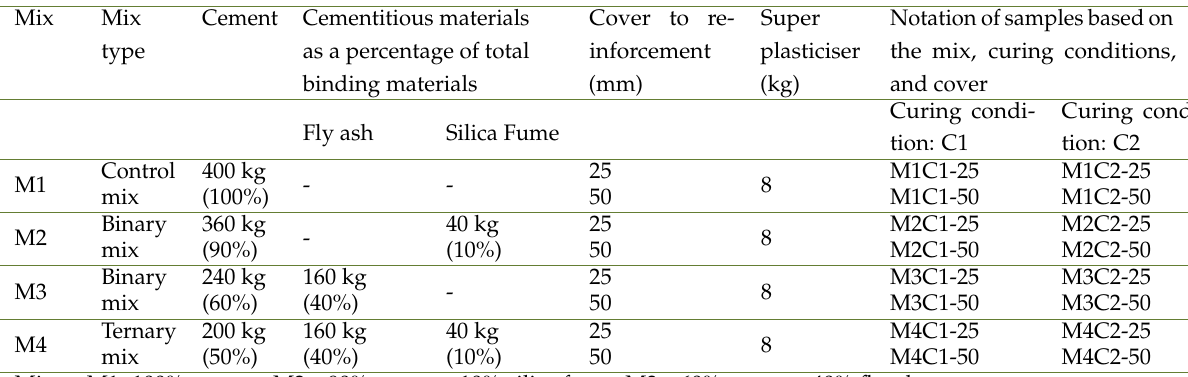
Table 2. Mixes and Notations of